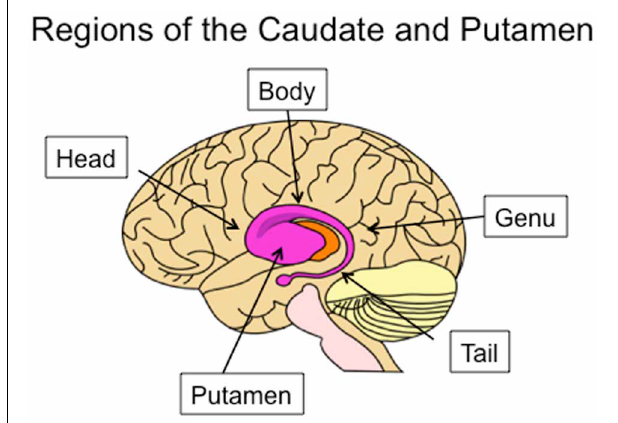
FIGURE 1 | Lateral view of the human caudate and putamen, situated within a transparent brain. The subregions of the caudate are indicated: the head, body, genu, and tail.